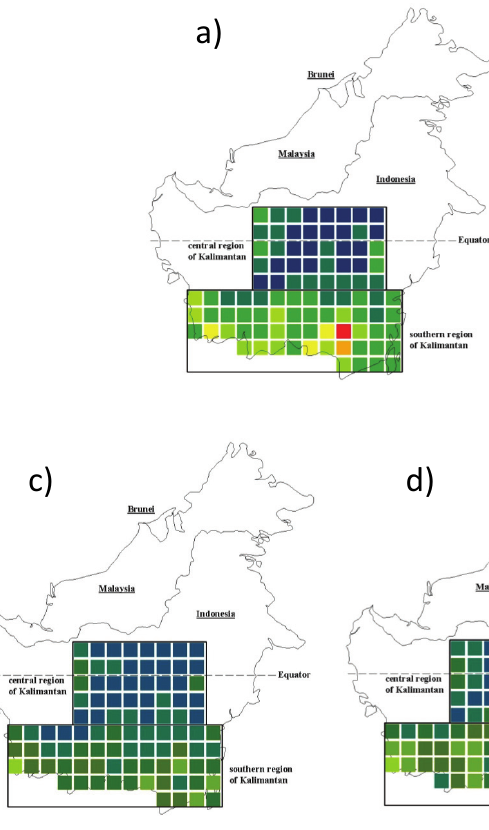
Figure 1. The island of Borneo showing burnt and fire-affected area (top) and tree cover patterns (bottom) across the southern-central region of Kalimantan: (a) total GFED4 burnt area, (b) total RSS fire-affected area, (c) mean 1993 tree cover, (d) mean 1997 tree cover, and (e) mean 2010 tree cover. Data are plotted at 0.5 ◦ grid-cell resolution. Number of 0.5 ◦ grid cells in southern Kalimantan is 53. Number of 0.5 ◦ grid cells in southern Kalimantan is